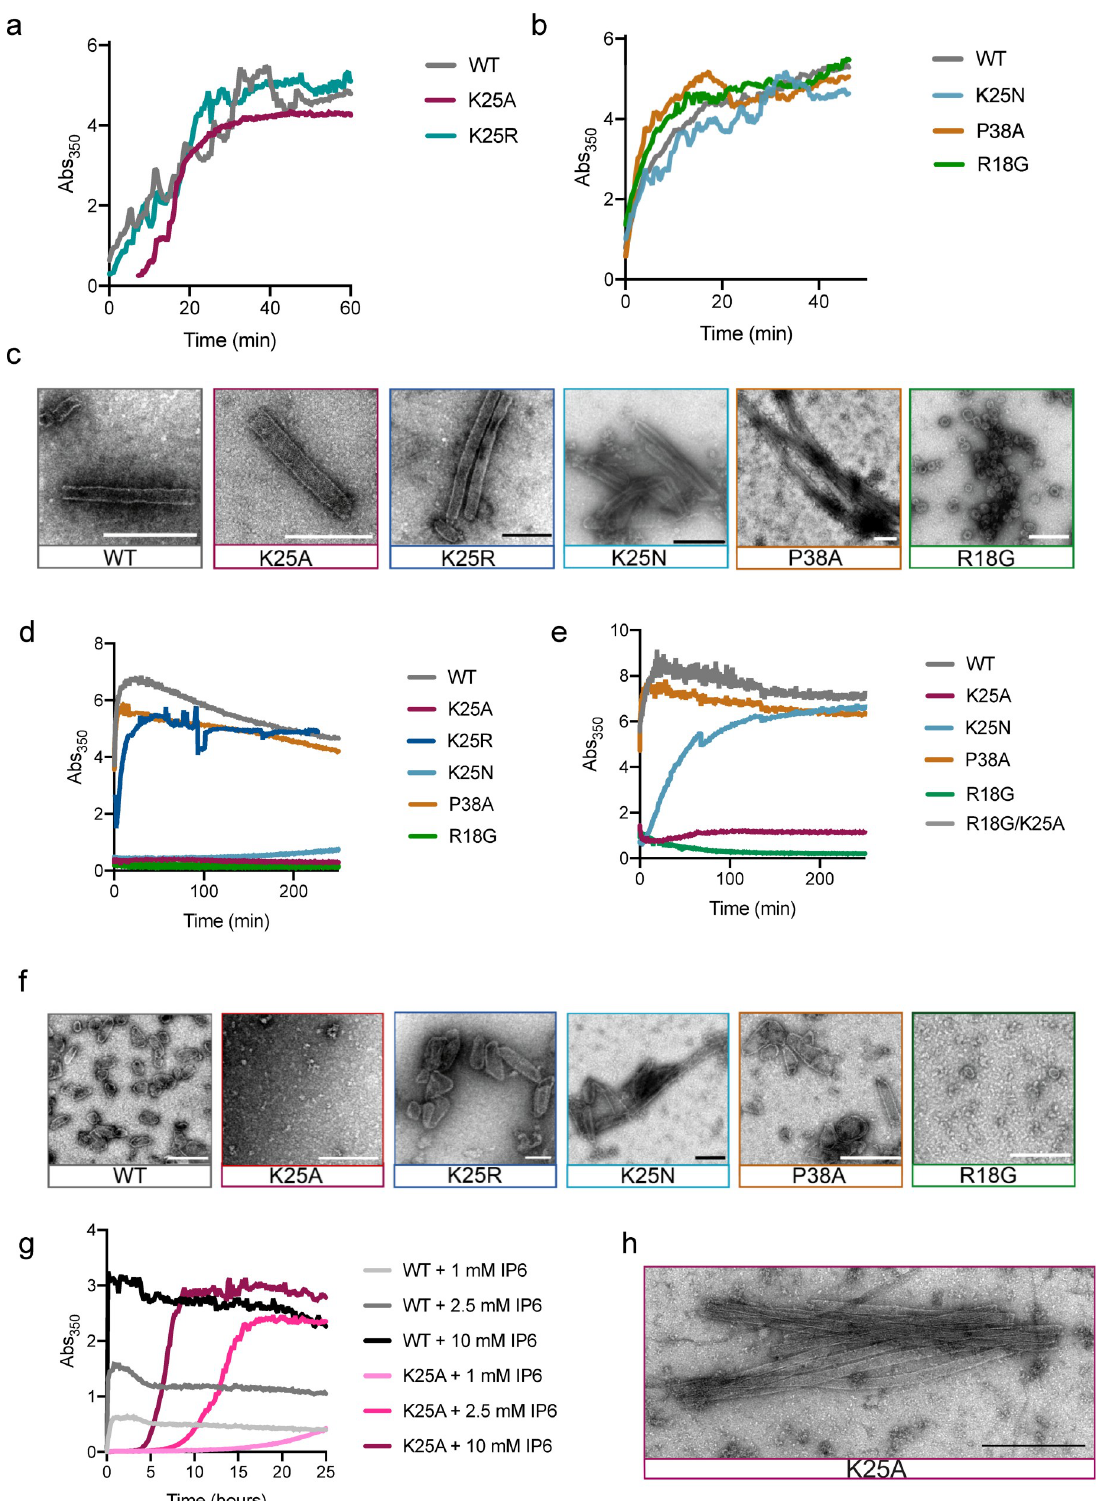
Fig 6. K25 is required for IP6-mediated assembly of HIV CA. In vitro assembly reactions were monitored in real-time be measuring the absorbance at 350 nm. (a&b) Assembly reactions using 75 μ M capsid protein and 2.5 M NaCl in 50 mM MES pH 6.0 (c) Negative stain EM images of material taken from (a&b). Scalebar: 200 nm. (d) Assembly reactions using 100 μ M WT and mutant capsid protein